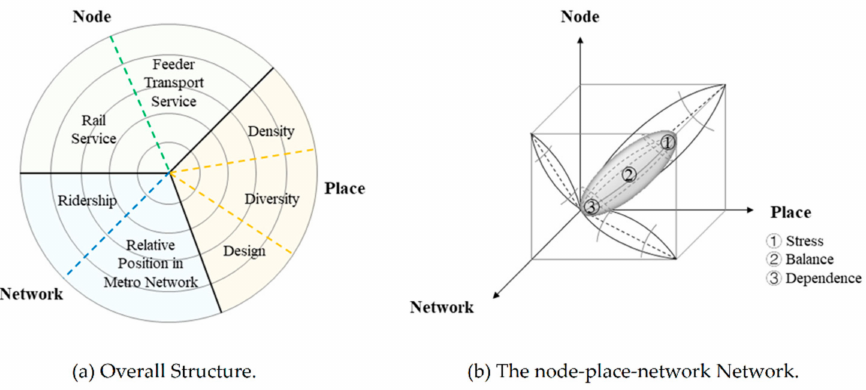
Figure 3. Illustrations of the node-place-network model. ( a ) Overall structure, ( b ) the node-place- network network